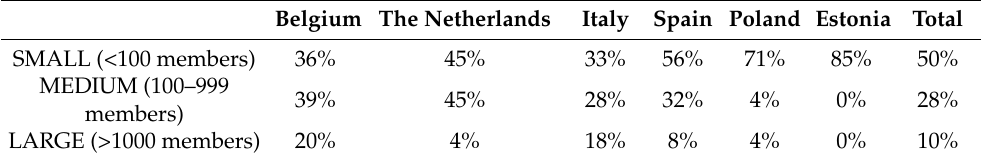
Table 4. CAIs’ Size.